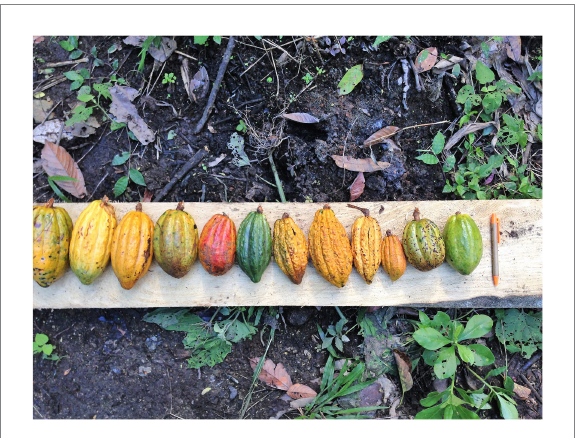
FIGURE 1 Cacao pods. Credit: Lavoie, A. 2017 Echarate, Peru.